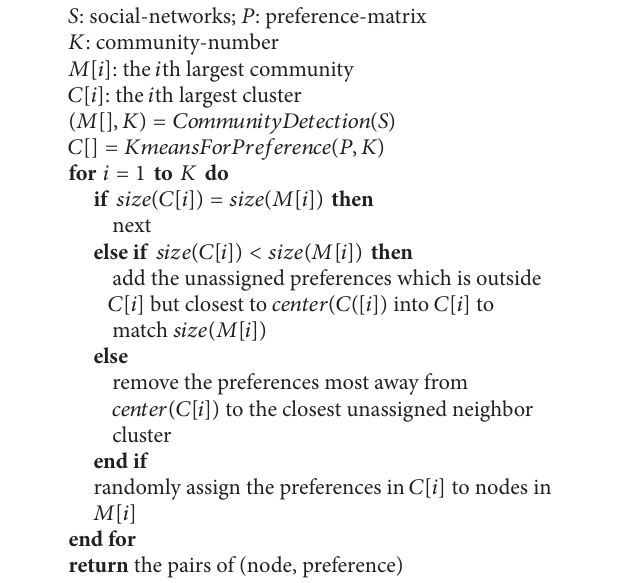
Algorithm 2: Preference deployment method.